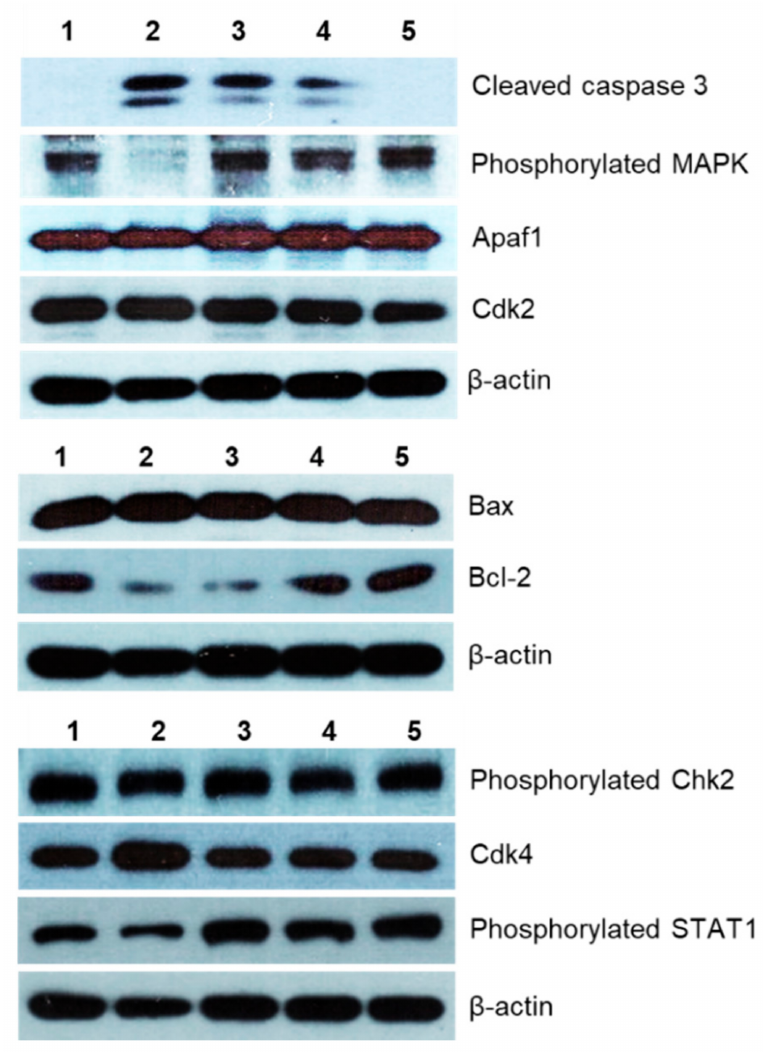
Figure 6. The level of apoptosis- and cell cycle-associated proteins in HCT116 cells after 48 h treatment with different agents (Western-blot analysis data): 1–control (non-treated) cells, 2–doxorubicin (Dox, 0.9 µ g/mL), 3–MI-1 (0.9 µ g/mL), 4–MI-1/M5 complex (0.9 µ g/mL), 5–poly (PEGMA- co